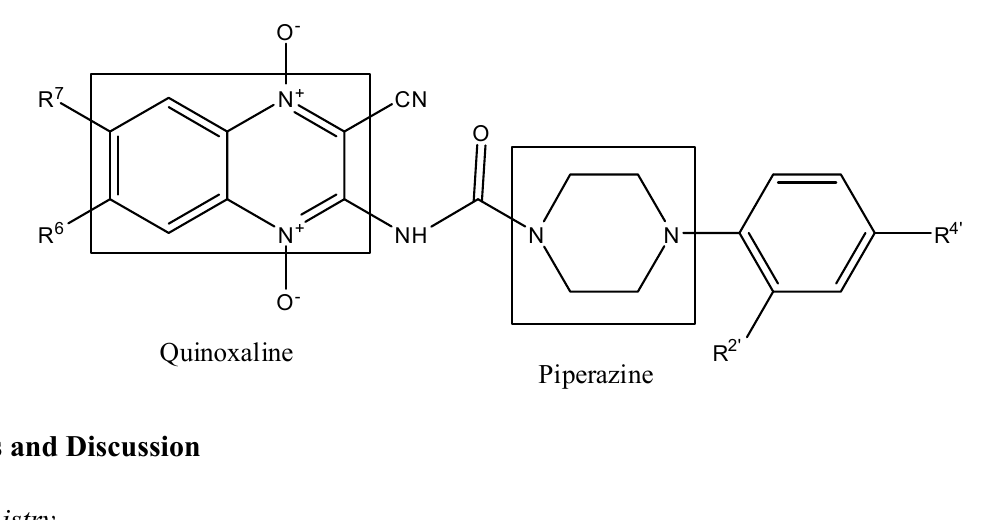
Figure 1. Design of new CPCQs as potential drugs against P. falciparum and L. infantum